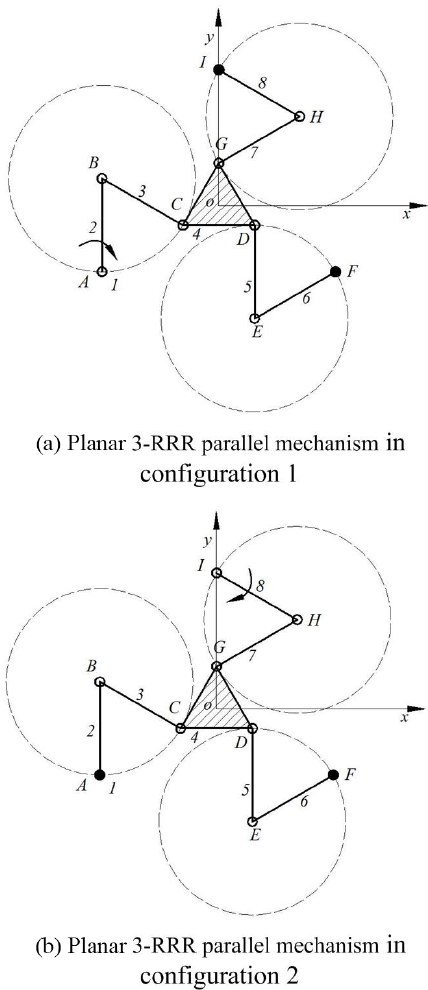
Figure 3. A packaging mechanism.